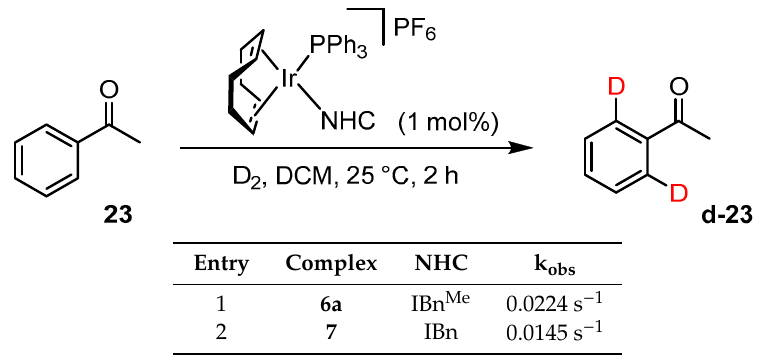
Table 4. Evaluation of complexes 6a and 7 in a benchmark HIE reaction.